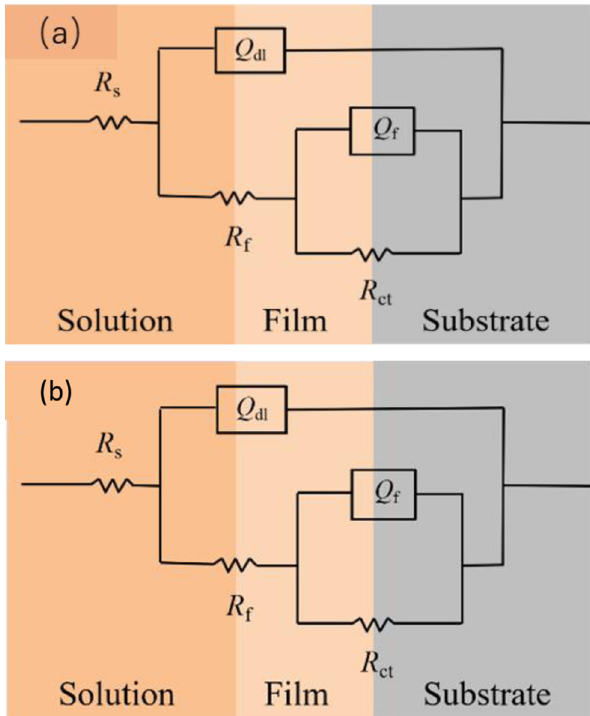
Figure 8: Equivalent circuit of EIS for coatings ( a ) in 5 mol · L − 1 HCl solution and equivalent circuit of EIS for coatings in 3.5 wt% NaCl solution for 120 h.